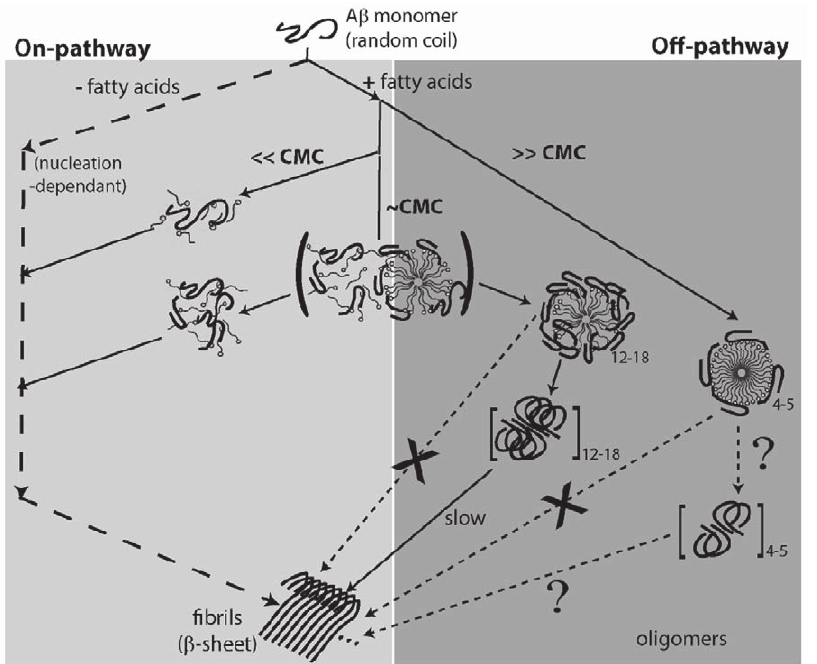
Figure 10. Schematic model of A b 42 aggregation pathways in the presence of NEFAs based on the data obtained in this study. The square brackets indicate isolated oligomers while the question mark indicates that these parts were not explored in this study.